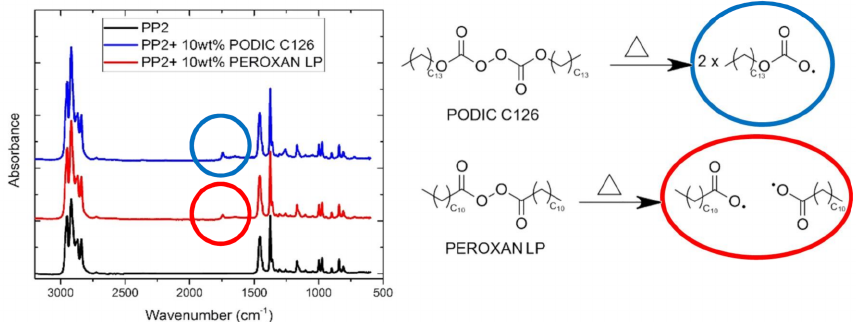
Figure 11. Fourier transform infrared (FTIR) spectra of the unmodified PP and the two LCB-PPs. To characterize whether the long-chain branches of the LCB-PPs based on PODIC C126 and PEROXAN LP are still present after blending at an extrusion temperature of 240 ◦